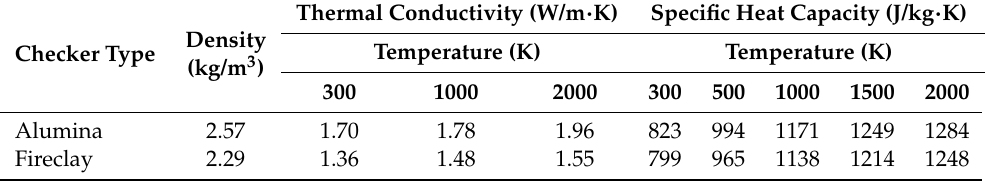
Table 2. Material properties of the checker bricks.